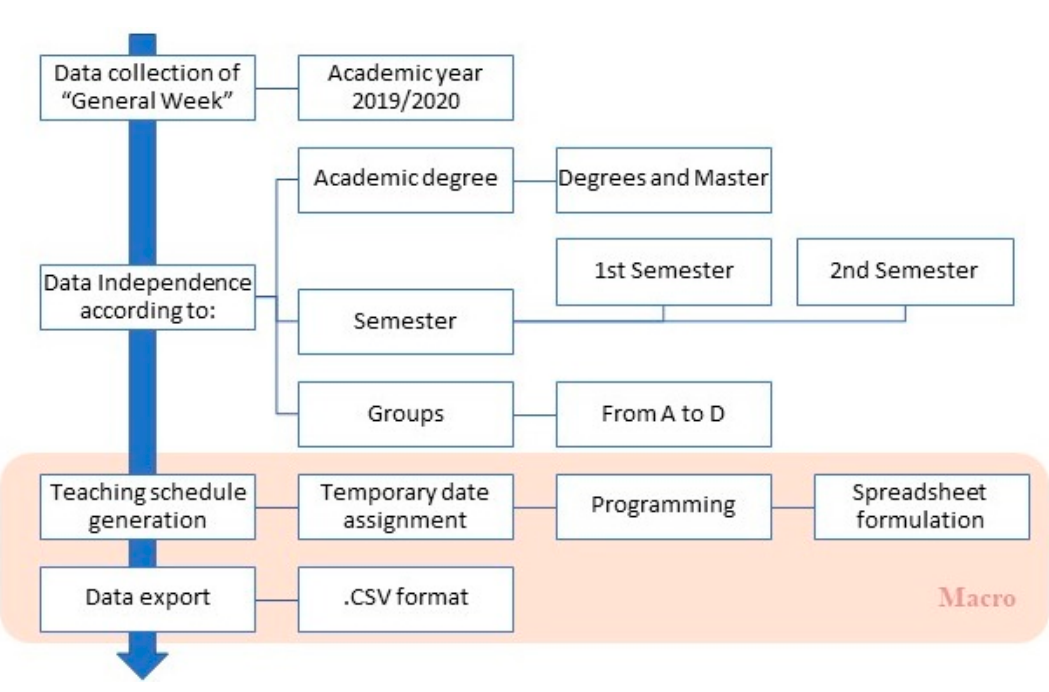
Figure 10. Collection and structure of educational data.